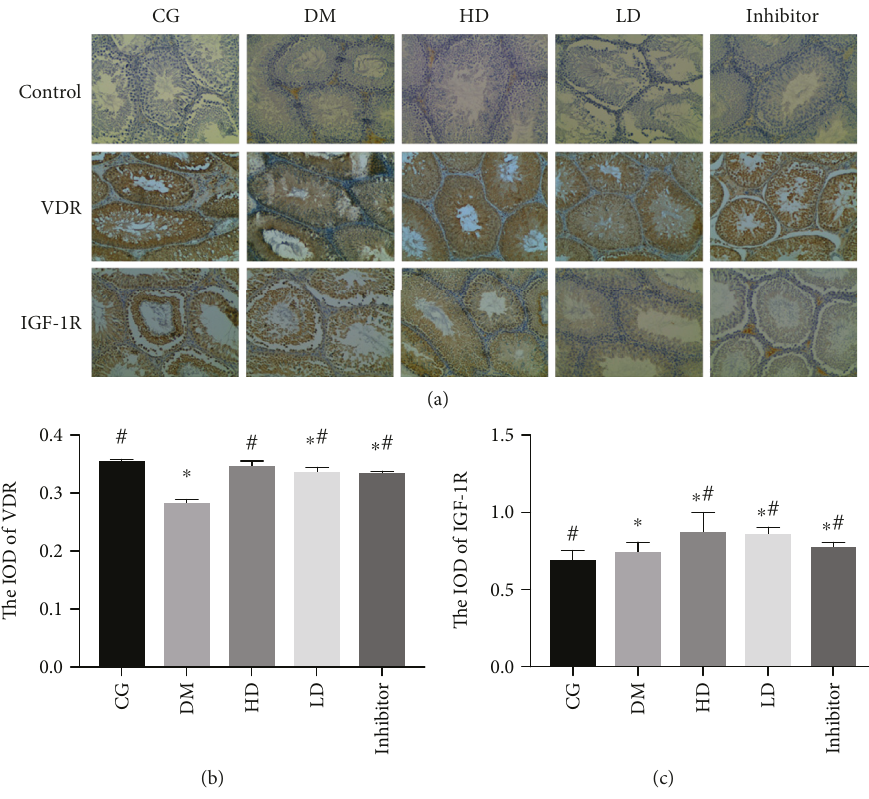
Figure 2: (a) Immunohistochemical analysis of the expression of VDR and IGF-1R in each group ( × 100). (b, c) Immunohistochemical analyses of VDR and IGF-1R in each group. IOD: integrated optical density. In groups treated with vitamin D, VDR expression was more strongly positive than that in the DM group. Compared with the DM group, the integrated optical density for other groups was signi fi cantly di ff erent ( p < 0 05 ). There were no signi fi cant di ff erences in VDR expression among the LD, HD, and CG groups ( p > 0 05 ). Immunohistochemical analysis showed that the expression of IGF-1R in the DM group was signi fi cantly lower than that in the CG, HD, and LD groups ( p < 0 05 ). ∗ p < 0 05 versus the CG group; # p < 0 05 versus the DM group.